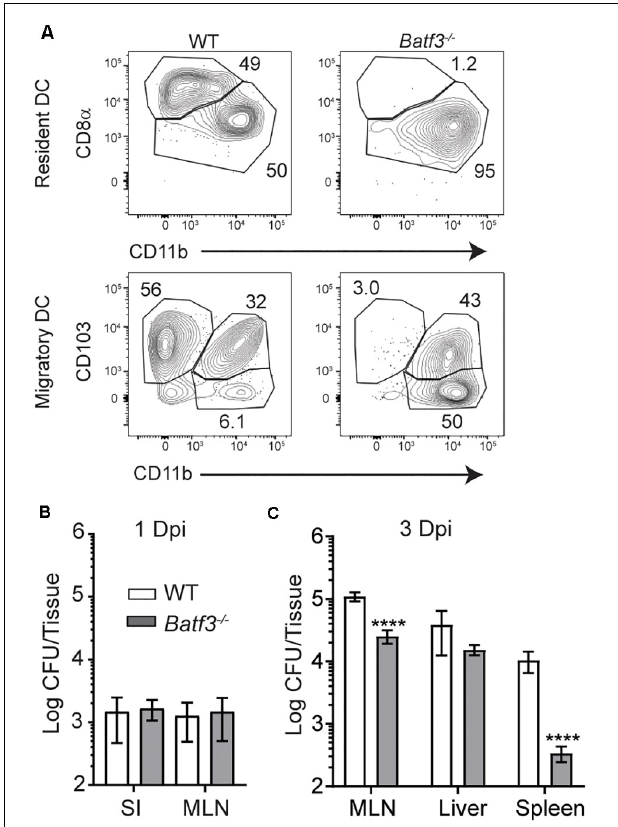
FIGURE 4 | Defects in InlA M Lm accumulation in the MLN after foodborne infection of Batf3 − / − mice. (A) WT and Batf3 − / − mice were infected with 1 × 10 10 CFU InlA M Lm 10403s. At 2 dpi, MLN cell suspensions were assessed by flow cytometry for DC. DC were identified as CD45 + CD19 − TCR β − F4/80 − Ly6C − MHCII hi CD11c int single, live leukocytes (migratory DC) or CD45 + CD19 − TCR β − F4/80 − Ly6C − MHCII + CD11c hi single,